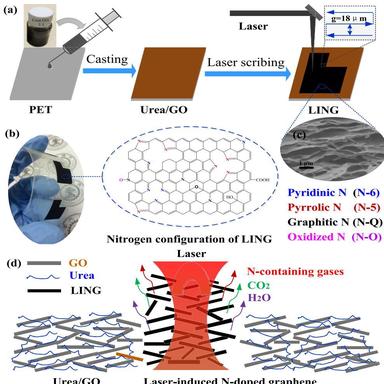
(a) Schematic illustration of the formation of LING material by laser induction on GO/urea film. The inset in the upper right corner is a schematic diagram of a high repetition rate picosecond laser processing route on the GO/urea film. (b) Digital photograph of LING-electrodes adhered to the flexible PET substrate. The area induced by the laser turns into nitrogen-doped graphene (black region) with defects. (c) Cross sectional SEM images of LING film showing a porous 3D framework. (d) The LING nanosheets d